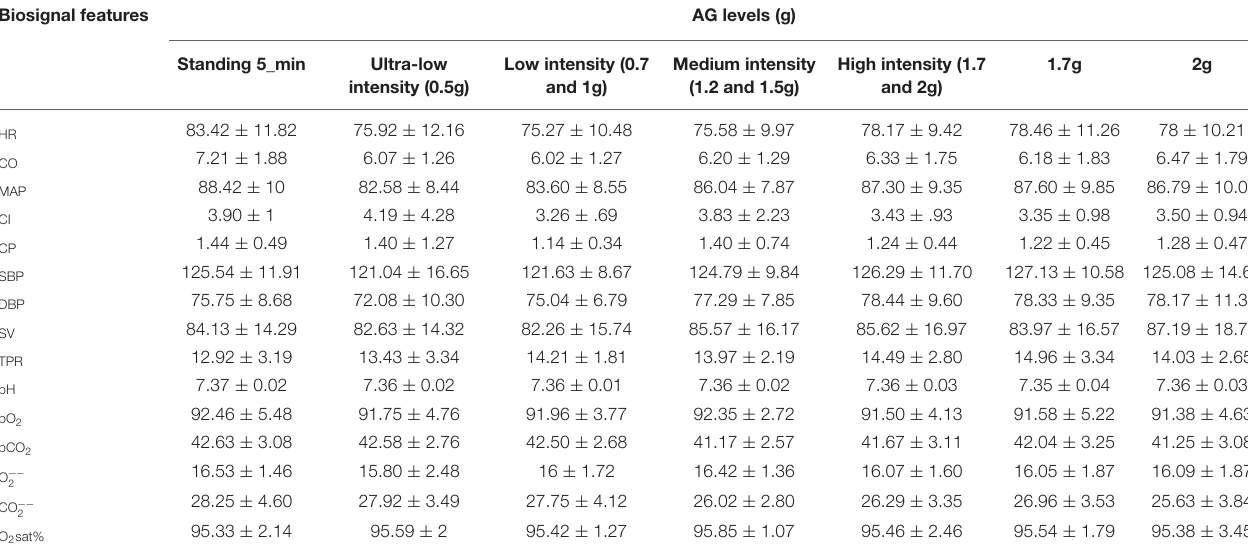
TABLE 4 | Mean ( M ) ± Standard Deviations (SD) of 15 biosignal features for the five AG levels, where the high intensity level due to its significance compared to standing, it was presented separately as 1.7 and 2.0g. Biosignal